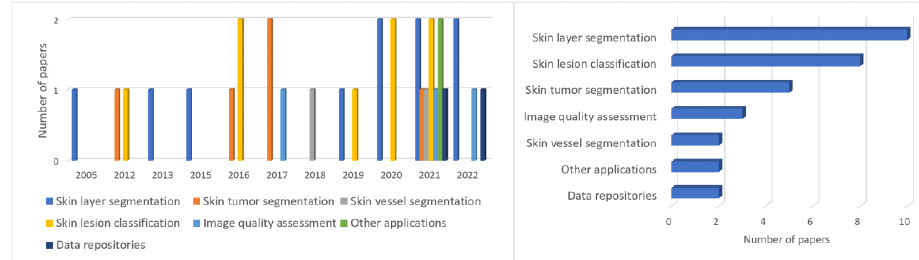
Figure 1. Timeline of the CAD algorithms developed for HFUS imaging analysis and their breakdown into categories based on